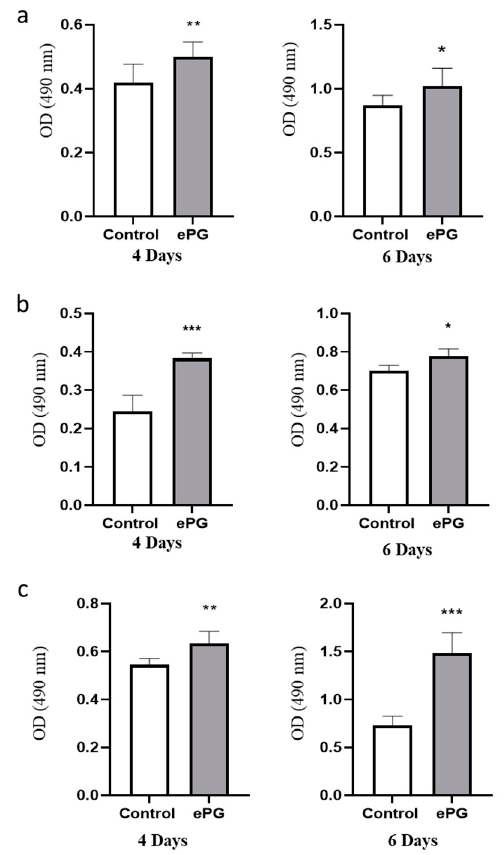
Figure 5. Enhanced proliferation induced by ePG in three human PDAC cell lines. ( a ) PANC1 cells, ( b ) MIA PaCa-2, and ( c ) BxPC-3 cells were cultured in hypoxia alone or with ePG (MOI 10). Extracellular bacteria were killed with antibiotics after one hour of infection, and cell proliferation was determined by MTS after 4 or 6 days. Two-tailed t -test was performed for statistical analysis. * p ≤ 0.05, ** p ≤ 0.01, *** p ≤ 0.005.